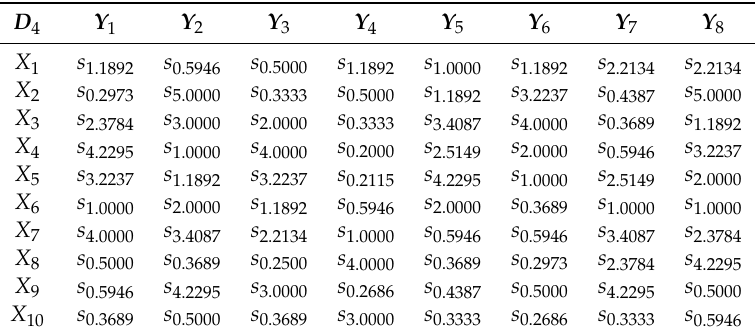
Table A9. Deterministic linguistic evaluation information matrix of D 4 .